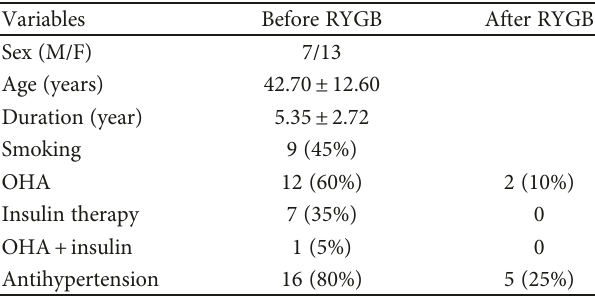
Table 1: Study population characteristics in T2DM patients with obesity at baseline ( n = 20